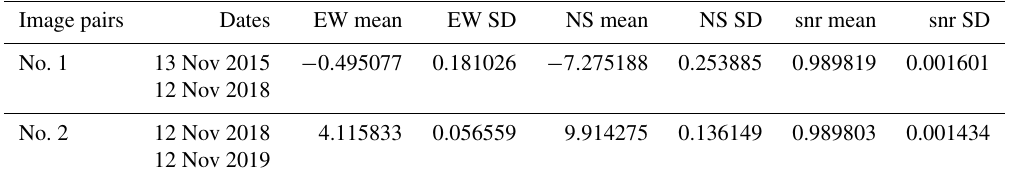
Table 3. Detected image shifts (system error) in the stable zone. The EW (east–west) SD and NS (north–south) SD indicate uncertainties in the method, and the EW mean and NS mean were used to derive the final displacements in image pairs no. 1 and no. 2. The signal-to-noise ratio is denoted by